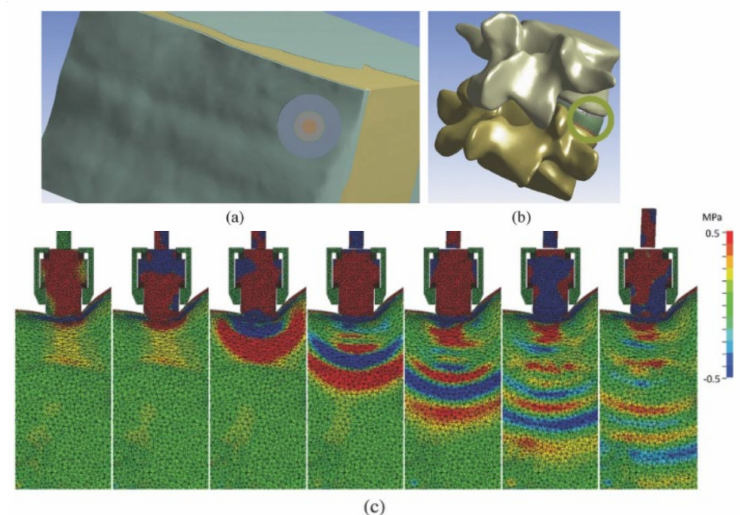
Figure 4. Shockwave propagation through the soft tissue to the spinal cord; simulation using finite element analysis; ( a ) indicates the location where the analysis was performed; ( b ) indicates the area of interest of the spinal cord; ( c ) shows a conventional applicator in direct contact with soft tissue and the induced shockwaves propagation [23].